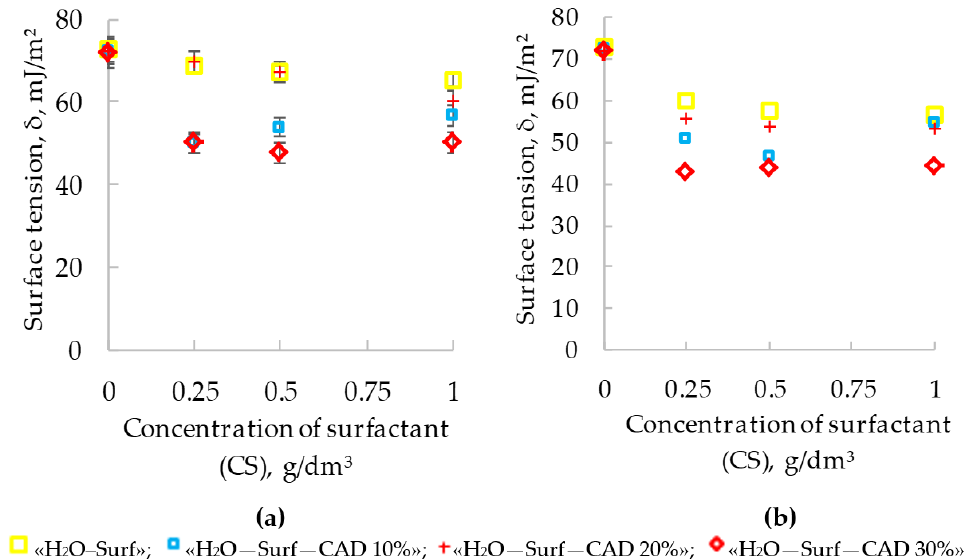
Figure 2. Surface tension isotherms (T = 298 K) in systems: ( a ) NaPA, ( b ) PC. Both studied additives (NaPA and PC; Figure 2) lowered the surface tension both in pure water and in the presence of acrylic varnish (CAD 10, 20, and 30%). Therefore, NaPA and PC in this system should be considered as surfactants.